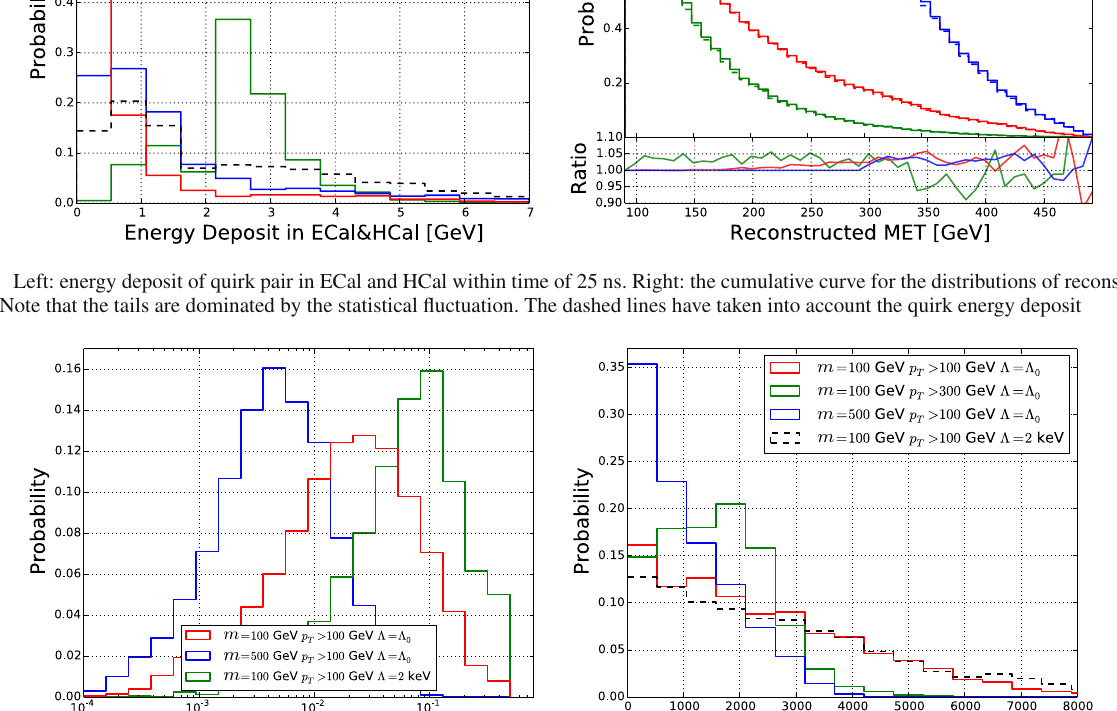
After numerical simulation as introduced in Ref.